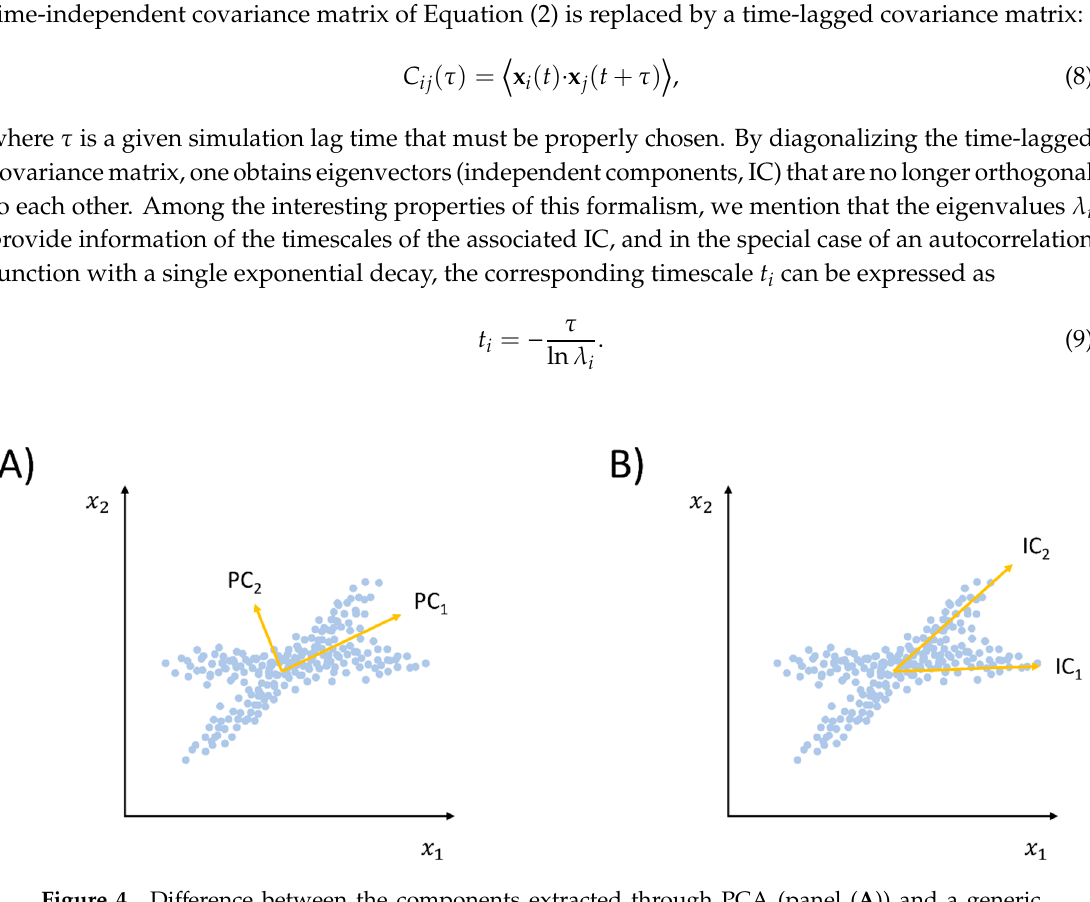
Figure 4. Difference between the components extracted through PCA (panel ( A )) and a generic independent coordinate analysis (ICA) method (panel ( B )). In specific cases, ICA provides a better description of the high-d data structure, as the eigenvectors identified are not necessarily restrained to the orthogonality relationship.